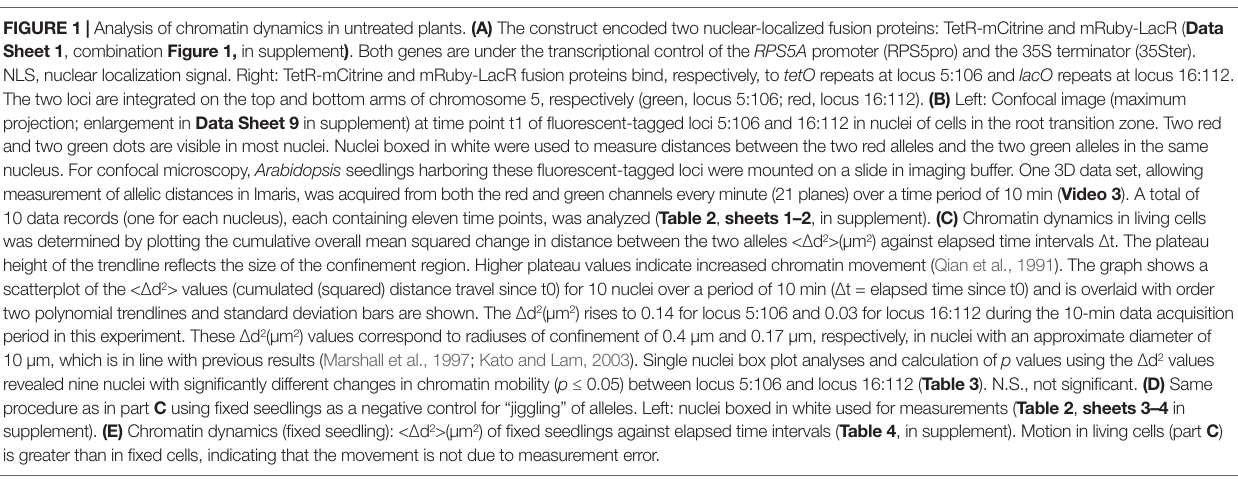
FIGURE 1 | Analysis of chromatin dynamics in untreated plants. (A) The construct encoded two nuclear-localized fusion proteins: TetR-mCitrine and mRuby-LacR ( Data Sheet 1 , combination Figure 1, in supplement ) . Both genes are under the transcriptional control of the RPS5A promoter (RPS5pro) and the 35S terminator (35Ster). NLS, nuclear localization signal. Right: TetR-mCitrine and mRuby-LacR fusion proteins bind, respectively, to tetO repeats at locus 5:106 and lacO repeats at locus 16:112. The two loci are integrated on the top and bottom arms of chromosome 5, respectively (green, locus 5:106; red, locus 16:112). (B) Left: Confocal image (maximum projection; enlargement in Data Sheet 9 in supplement) at time point t1 of fluorescent-tagged loci 5:106 and 16:112 in nuclei of cells in the root transition zone. Two red and two green dots are visible in most nuclei. Nuclei boxed in white were used to measure distances between the two red alleles and the two green alleles in the same nucleus. For confocal microscopy, Arabidopsis seedlings harboring these fluorescent-tagged loci were mounted on a slide in imaging buffer. One 3D data set, allowing measurement of allelic distances in Imaris, was acquired from both the red and green channels every minute (21 planes) over a time period of 10 min ( Video 3 ). A total of 10 data records (one for each nucleus), each containing eleven time points, was analyzed ( Table 2 , sheets 1–2 , in supplement). (C) Chromatin dynamics in living cells was determined by plotting the cumulative overall mean squared change in distance between the two alleles <Δd 2 >(μm 2 ) against elapsed time intervals Δt. The plateau height of the trendline reflects the size of the confinement region. Higher plateau values indicate increased chromatin movement (Qian et al., 1991). The graph shows a scatterplot of the <Δd 2 > values (cumulated (squared) distance travel since t0) for 10 nuclei over a period of 10 min (Δt = elapsed time since t0) and is overlaid with order two polynomial trendlines and standard deviation bars are shown. The Δd 2 (μm 2 ) rises to 0.14 for locus 5:106 and 0.03 for locus 16:112 during the 10-min data acquisition period in this experiment. These Δd 2 (μm 2 ) values correspond to radiuses of confinement of 0.4 μm and 0.17 μm, respectively, in nuclei with an approximate diameter of 10 μm, which is in line with previous results (﻿arshall et al., 1997; Kato and Lam, 2003). Single nuclei box plot analyses and calculation of p values using the Δd 2 values revealed nine nuclei with significantly different changes in chromatin mobility ( p ≤ 0.05) between locus 5:106 and locus 16:112 ( Table 3 ). N.S., not significant. (D) Same procedure as in part C using fixed seedlings as a negative control for “jiggling” of alleles. Left: nuclei boxed in white used for measurements ( Table 2 , sheets 3–4 in supplement). (E) Chromatin dynamics (fixed seedling): <Δd 2 >(μm 2 ) of fixed seedlings against elapsed time intervals ( Table 4 , in supplement). ﻿otion in living cells (part C